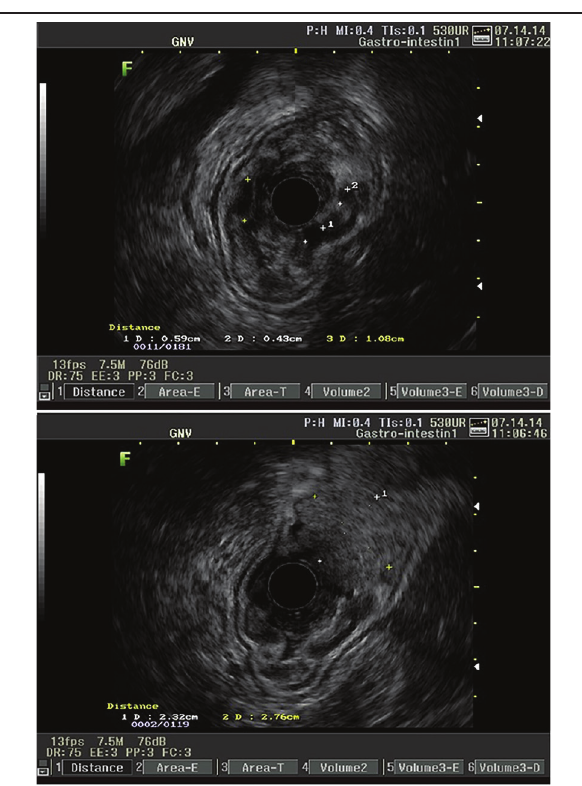
figurE 4 − High echoendoscopy evidencing polypoid lesion in the transitional body- antrum gastric zone and diffuse thickening of gastric folds with anechoic mucous cysts A subsequent echoendoscopy was performed as a complementary propaedeutic in order to rule out other possible differential diagnoses or associated diseases, considering the figurE 5 − Control gastrointestinal endoscopy evidencing hypertrophy of gastric mucosa 8-year evolution of the disease, uncommon in cases of folds, diffuse polypoid lesions and elevated lesion in body-antrum transitional zone